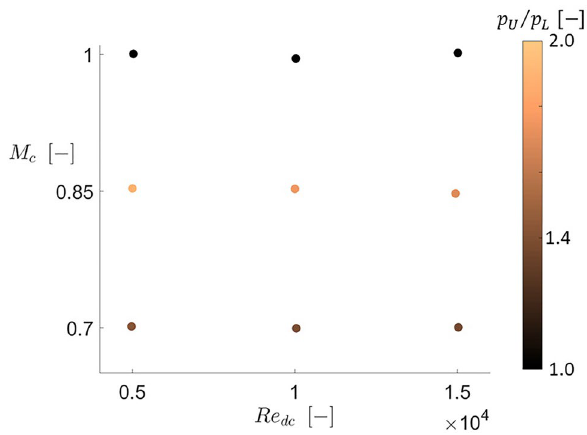
Figure 16. Coanda parametric study cooling Reynolds and Mach number map colored with the ratio of mean static pressure on both sides of the leading edge.